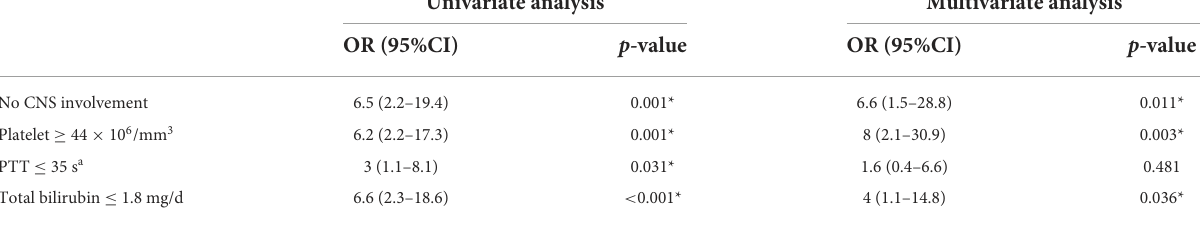
TABLE 4 Predictors of early treatment response in HLH patients.